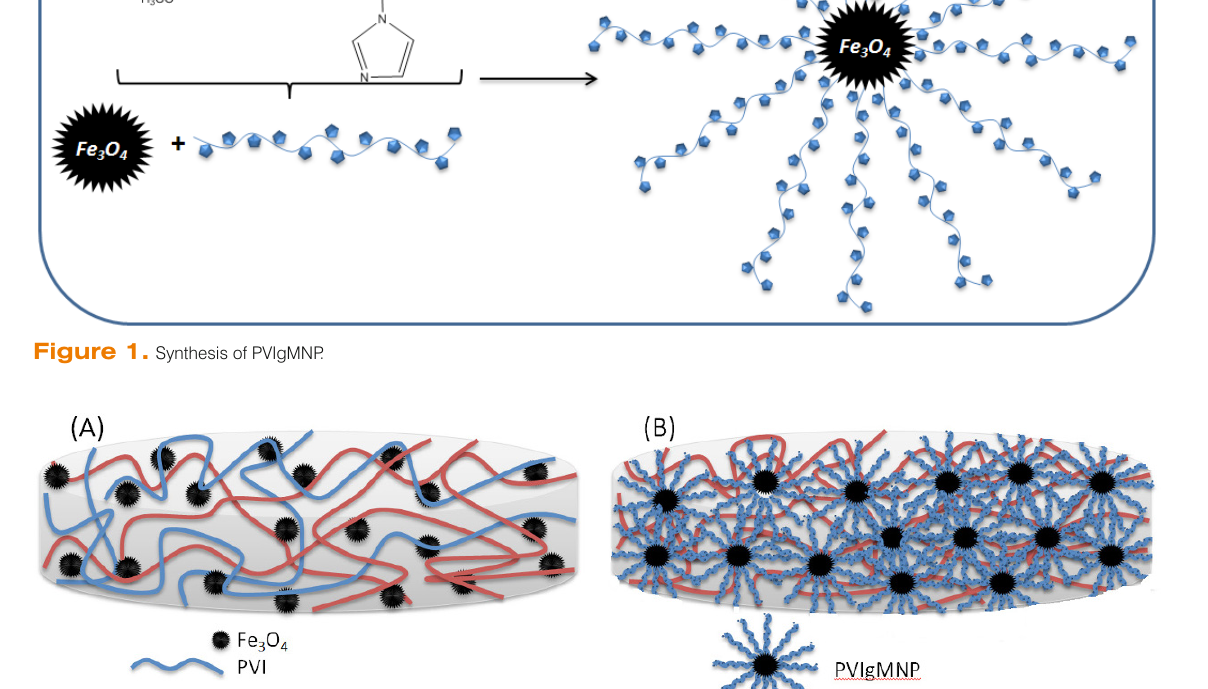
Figure 2. Proposed structure of (a) NPE-1,2 and (b) NPE3,4 nanocomposite polymer